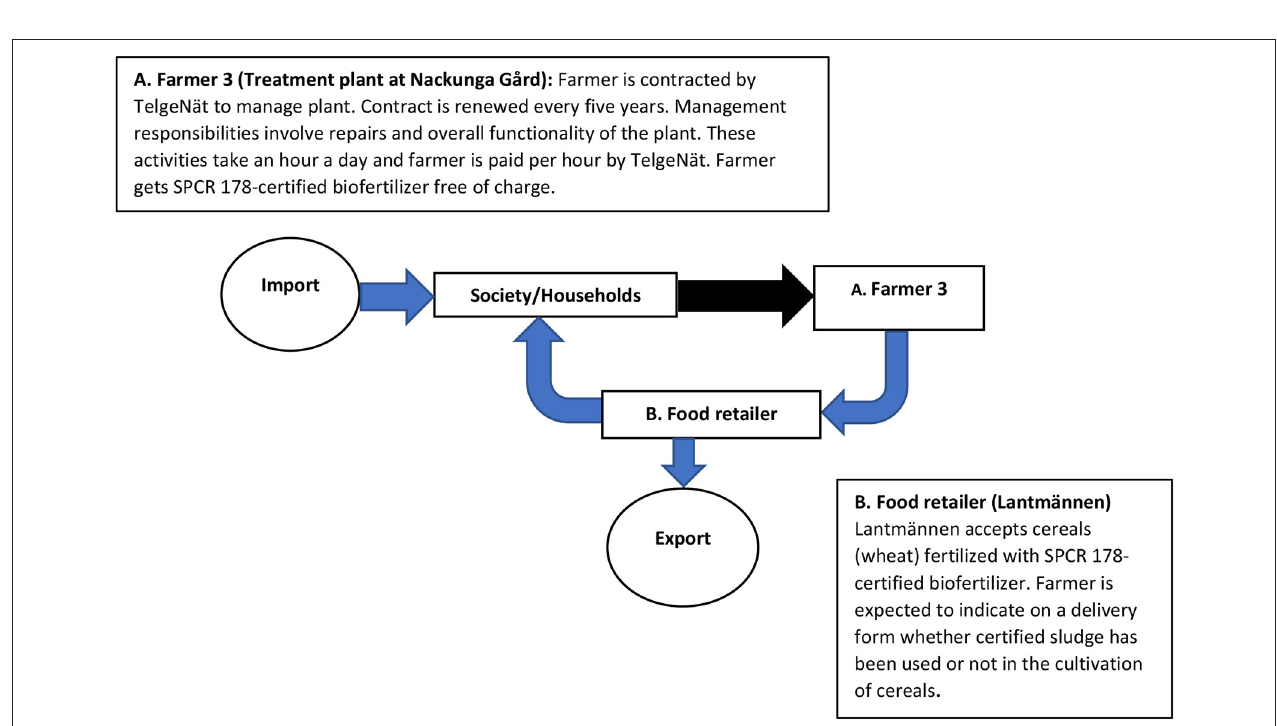
FIGURE 1 | Distribution of REVAQ-certified sludge—WWTP to farm and farm to market.